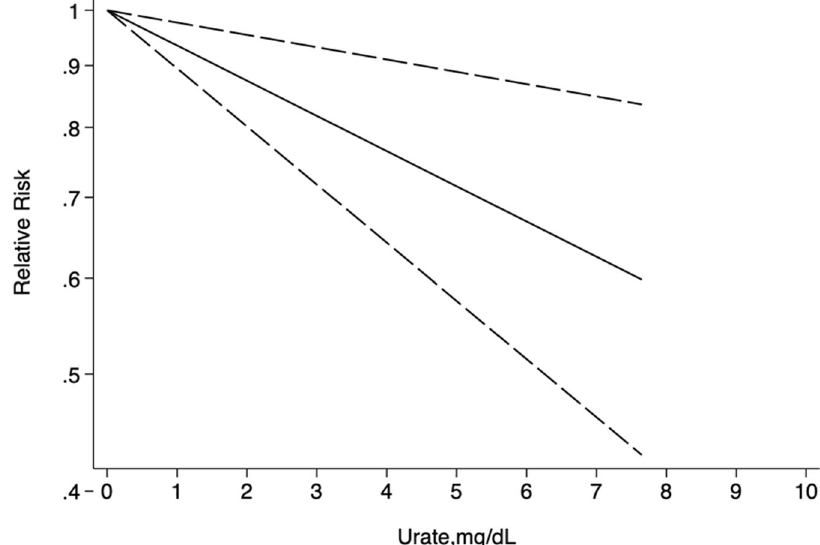
Fig. 5 Dose – response correlation between urate levels and PD risk. Restricted cubic spline revealed a negative linear